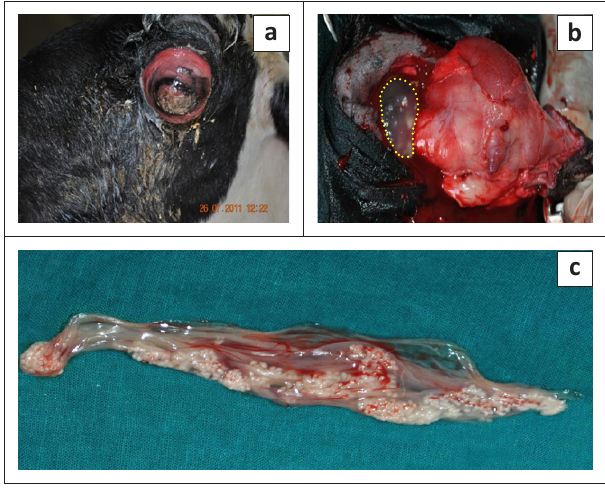
FIGURE 1: (a) Photograph of a ewe suffering from orbital coenurosis showing blepharitis, congestion of the conjunctiva and enlargement and protrusion of the eye ball; (b) coenurus cyst observed during enucleation of the eye (dotted line) located retrobulbarly in the periocular fat as a transparent cyst with white scolices and (c) scolices located in a longitudinal line at one side of the cyst.